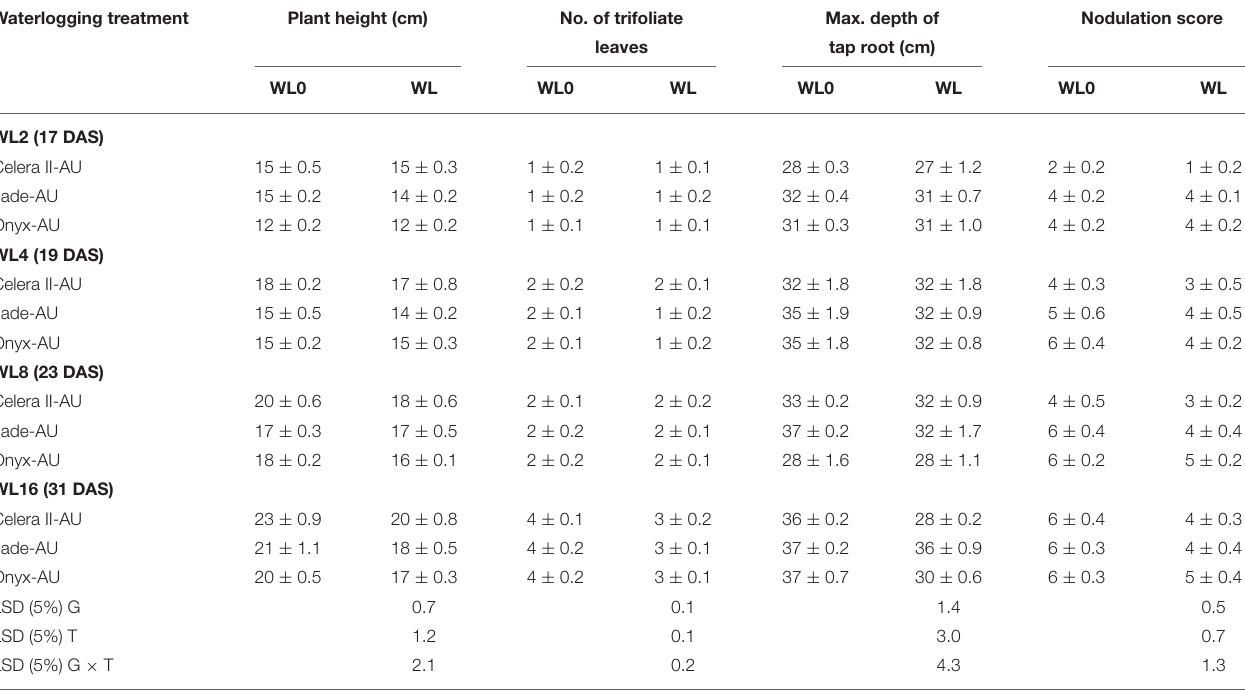
TABLE 4 | Plant height, number of trifoliate leaves, taproot depth, and nodulation score after different waterlogging durations. Waterlogging treatment Plant height (cm) No. of trifoliate Max. depth